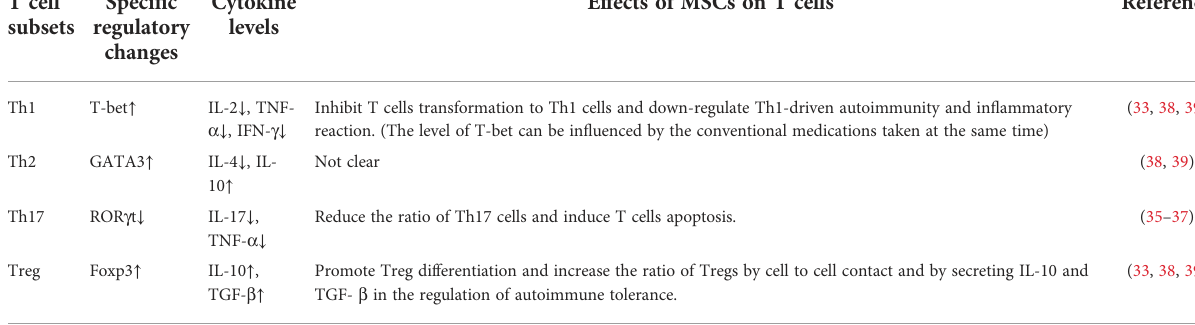
TABLE 1 Immunomodulatory Effects of MSCs on the T cell